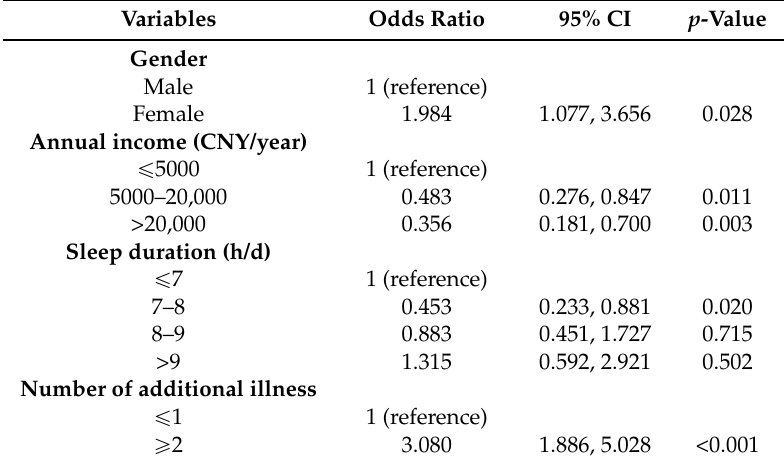
Table 2. Multivariate analysis of factors associated with depressive symptom among diabetic residents *. Variables Odds Ratio 95% CI p -Value Gender Male 1